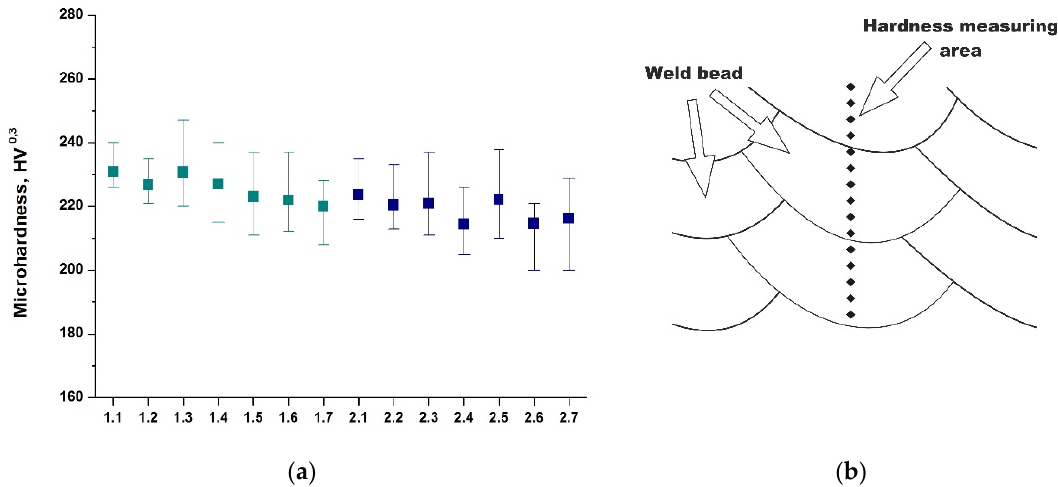
Figure 10. Microhardness of the deposited samples: ( a ) microhardness graph; ( b ) microhardness scheme. The micro-hardness curve (Figure 10) shows that the scatter at a pause of 5 min is greater than at a pause of 2.5 min in samples 1.1 and 1.2. In the samples of 2200 W, the scatter of values is approximately the same. It is concluded by that with increase of power of laser radiation in samples the homogeneous structure with uniform distribution of microhardness is formed. At power of 2600 and 2400 W the microhardness in samples is equally distributed. The optimal admissible power is reached in a mode with power of 2600–2400 W (mode 1.1, 1.2 and 2.1, 2.2). The mechanical properties of the deposited samples are higher than those of the conventionally produced samples. This is due to the formation of a well-directed dendritic structure. In samples obtained by traditional casting or rolling, the 316L microstructure consists of ferrite dendrites in an austenitic matrix. The grain size is rather large, due to which the mechanical properties have high ductility and impact toughness, and the ultimate strength is significantly lower compared to the deposited material [21]. The homogeneous dendritic structure throughout the height leads to an increase in the mechanical properties of the deposited specimen. In selecting the optimal DLD modes it is necessary to take into account the fact that the choice of pause must take account for the material overheating, which can affect the deformation of the workpiece. As can be seen in Table 4, the mechanical properties are almost identical at different pauses. Consequently, reducing the sample fabrication pause from 5 min to 2.5 min speeds up the preparation process for deposition large-size parts. Table 4. Mechanical properties. Samples 150 4. Conclusions In this study, two series of samples were made with different waiting time between the tracks. In this way, the thermal history of a large-sized product was simulated on small samples. We chose maximum possible working day conditions and 5 min waiting time between the layers. The second series of samples was made with a waiting time two times shorter of 2.5 min. Metallographic studies of the deposited technological samples were carried out. The percentage of discontinuities was determined within one macrosection